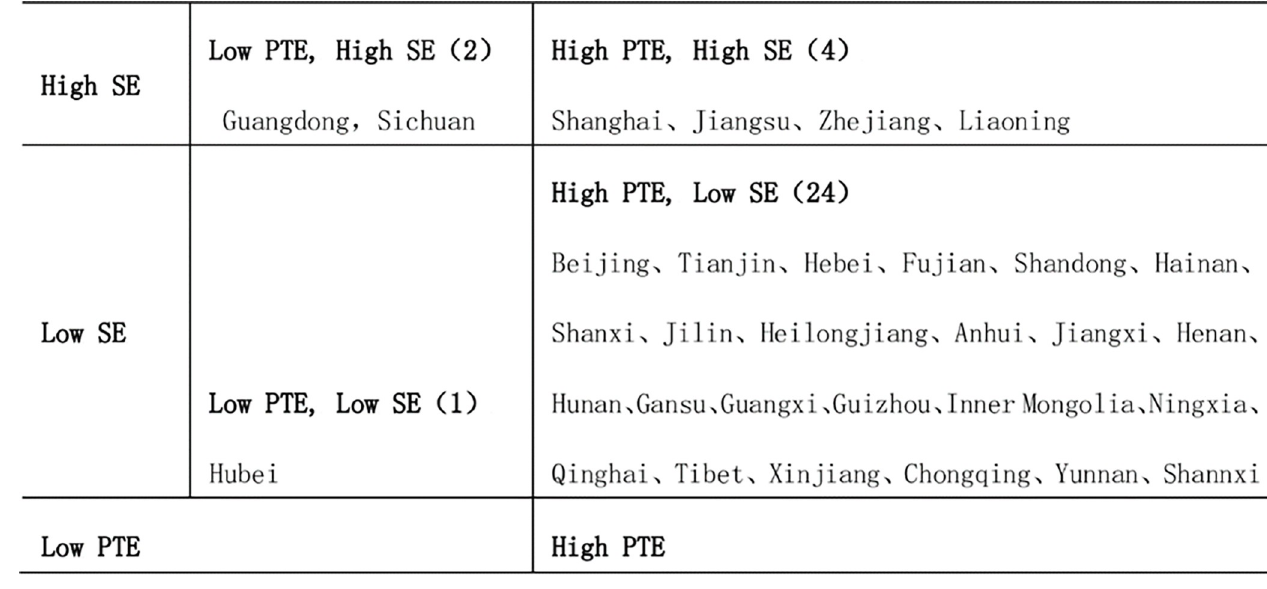
Fig 5. Efficiency distribution of each province in the Stage